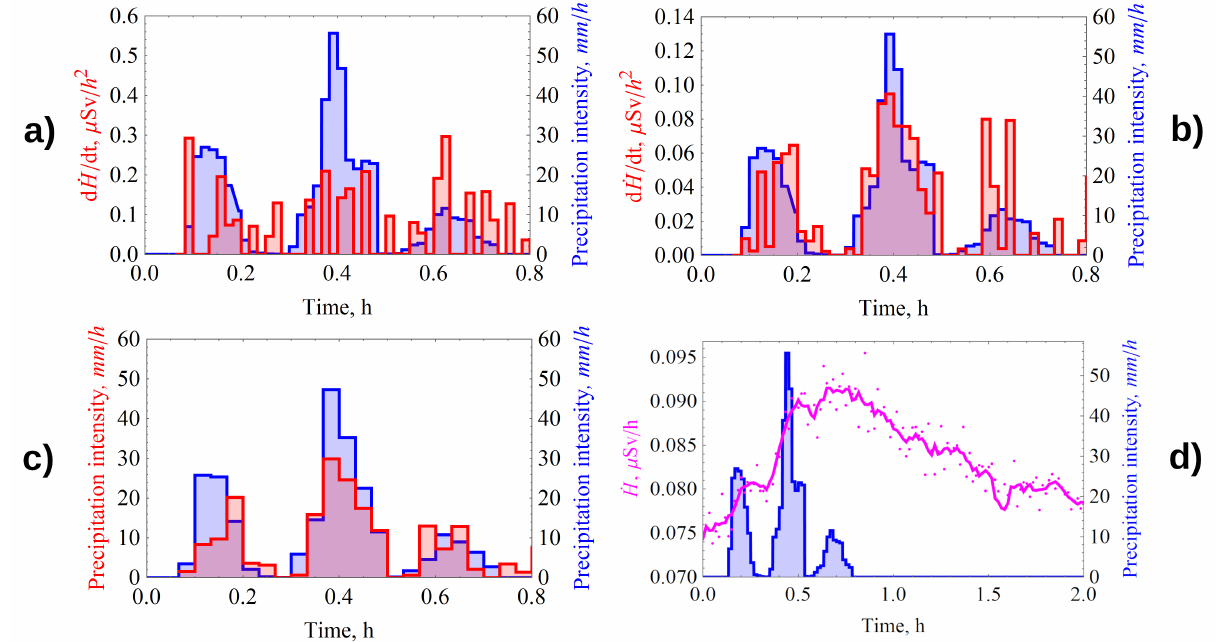
Figure 9. Dynamics of the measured precipitation intensity (blue) and time derivative of the measured dose rate (red) without smoothing ( a ), with smoothing by moving average ( b ), with averaging over 2 min ( c ), gamma radiation dose rate (pink) ( d